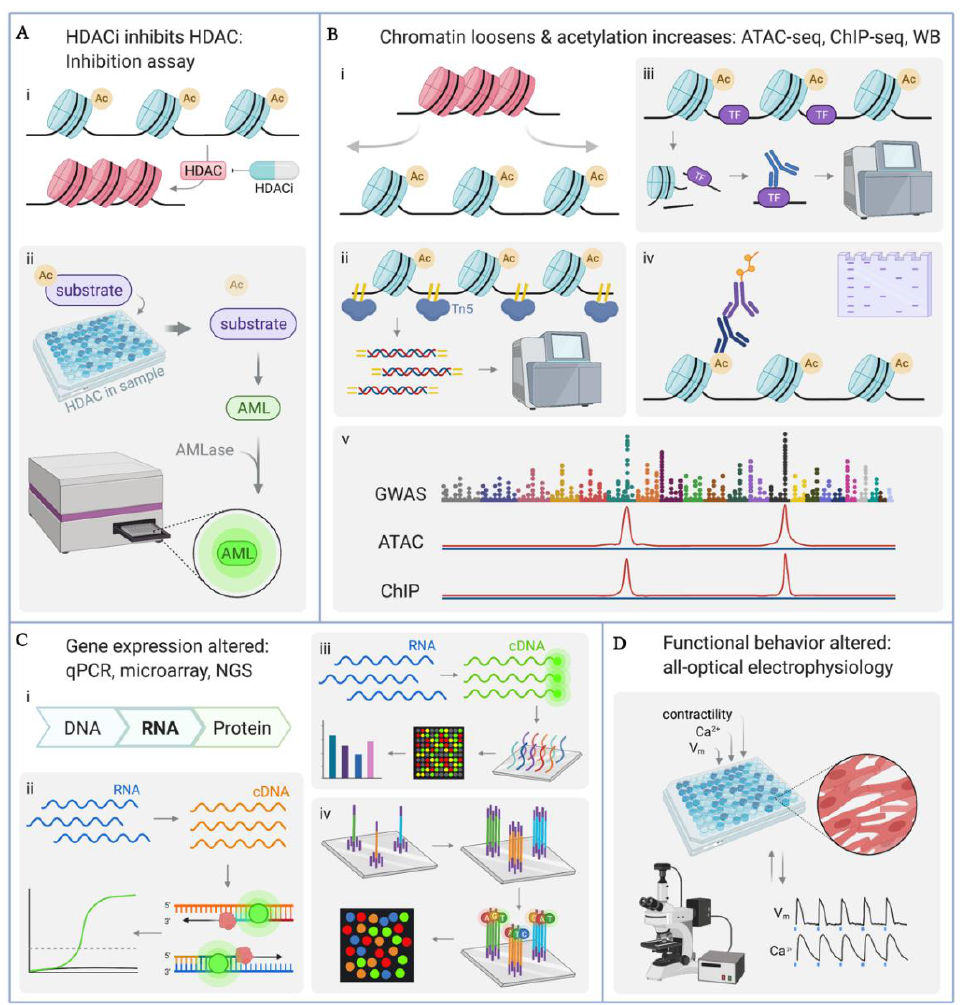
Figure 5. Methods for quantifying effects of HDACi. ( A ) (i) HDACs promote condensed chromatin structure and are counteracted by small-molecule HDACi pharmaceuticals. (ii) HDAC inhibition assay indirectly measures HDAC enzymatic activity. Aminoluciferin (AML), aminoluciferase (AM- Lase). ( B ) (i) Chromatin shifts from condensed (pink) to loose (blue) structure as histone acetylation increases. Chromatin accessibility can be measured by assay for transposase-accessible chromatin using sequencing (ATAC-seq) (ii) and chromatin immunoprecipitation followed by sequencing ChIP-seq (iii). Transcription factor (TF), Tn5 transposase (Tn5). (iv) Histone acetylation levels assayed with western blot (WB). “Ac” indicates acetylated histones. (v) ATAC-seq and ChIP-seq maps aligned to genome-wide association study (GWAS) maps to reveal areas of open chromatin where TFs of interest and phenotypes of interest are enriched. ( C ) (i) RNA quantification reflects gene expression. (ii) qPCR is a low-throughput fluorescence-based assay. (iii) Microarray assays are a high-throughput alternative to qPCR, allowing simultaneous detection and quantification of thousands of genes. cDNA indicates complementary DNA. (iv) Next-generation sequencing (NGS) is a high-throughput deep sequencing tool. ( D ) Functional behavior is assessed through contractility assays as well as all-optical electrophysiology recordings. Transmembrane potential (V m ), calcium transients (Ca 2+ ). Representative V m and Ca 2+ transients modified from [15]. Created with